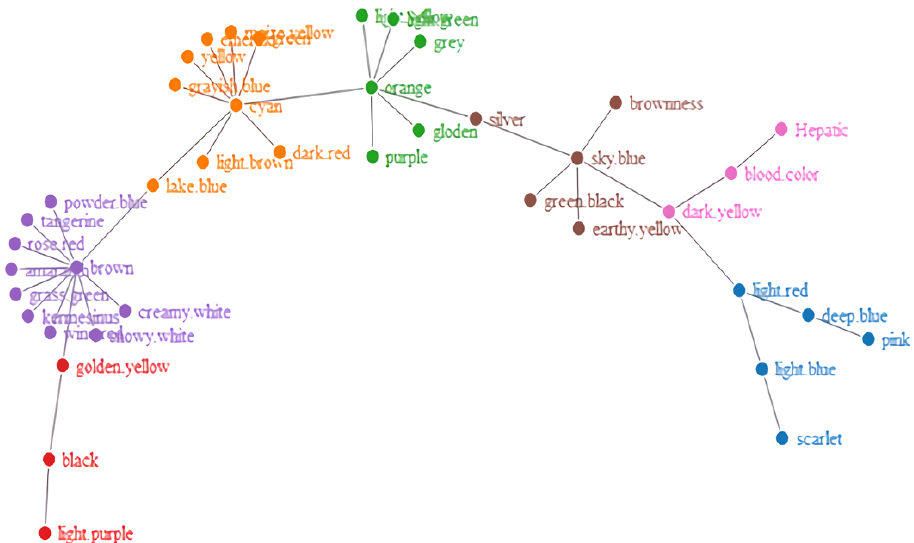
Figure 4. Network visualization of the Hakka-color lexical network.